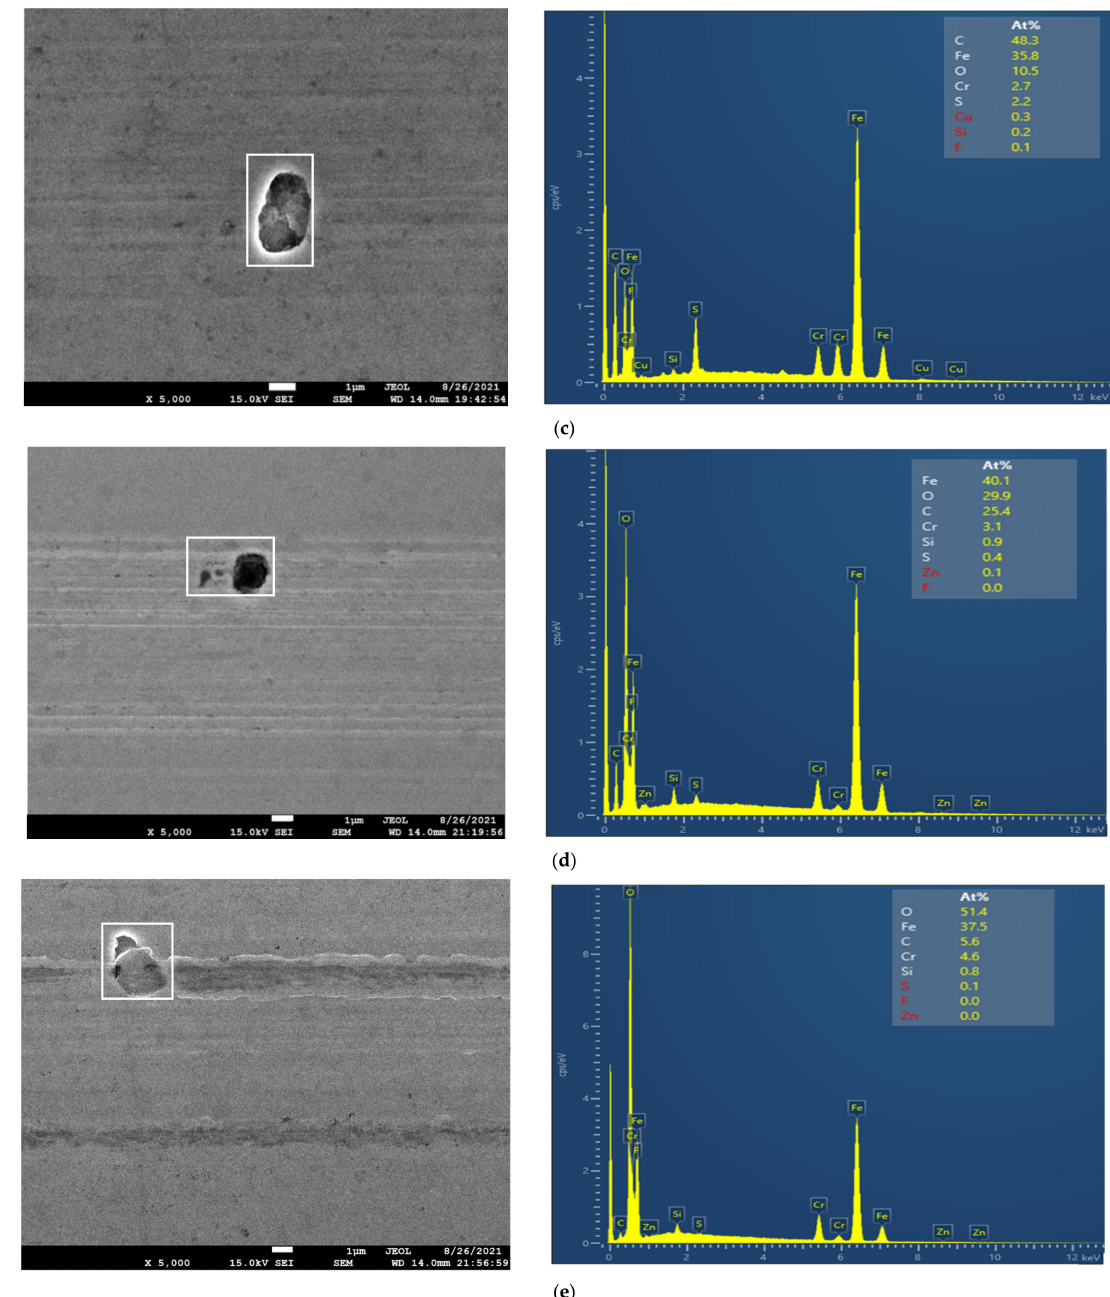
Figure 9. SEM micrographs of worn surface (left) and EDX analysis of defects (right) for the tests lubricated with the IL and different concentrations of nanoparticles: ( a ) IL, ( b ) IL + 0.2 wt% CuO, ( c ) IL + 0.5 wt% CuO, ( d ) IL + 0.2 wt% ZnO, and ( e ) IL + 0.5 wt%